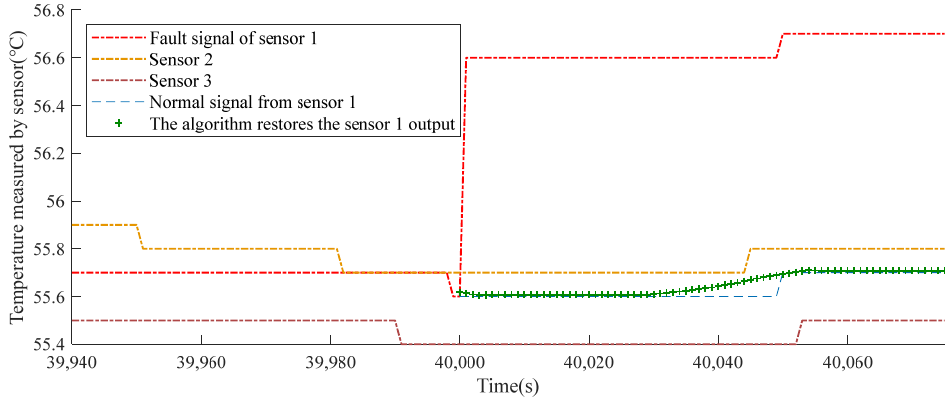
Appl. Sci. 2022 , 12 , x FOR PEER REVIEW Figure 11. The data recovery for the bias failure of a single sensor. Figure 11. The data recovery for the bias failure of a single sensor.